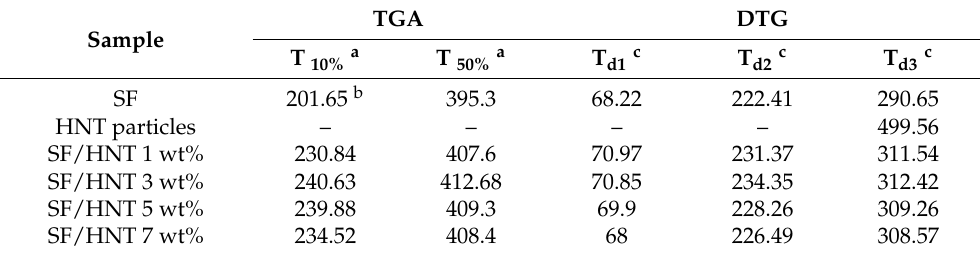
Figure 5. Comparison of thermal stability of SF scaffolds, SF/HNT composite scaffolds, and as- received HNTs: ( A ) TGA curves and ( B ) DTG, the three temperature peaks: d1, d2, and d3 are indicated. In both ( A ) and ( B ), the curves for SF/HNT 5 wt% are directly overlaid by SF/HNT 7 wt%, meaning only the latter is visible. Table 3. Thermal decomposition/stability of SF scaffolds, HNT particles, and SF/HNT composite